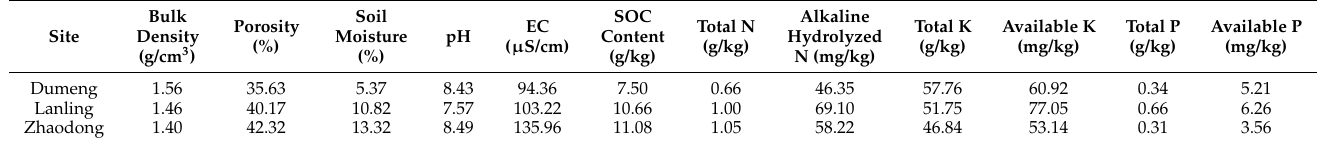
Figure 1. Distribution map of study sites in the Songnen Plain, northeastern China. Table 1. Soil properties sampling sites.